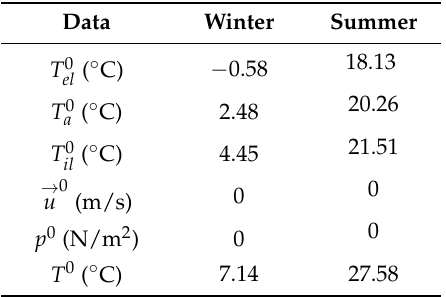
(cid:0) (cid:1) P façade